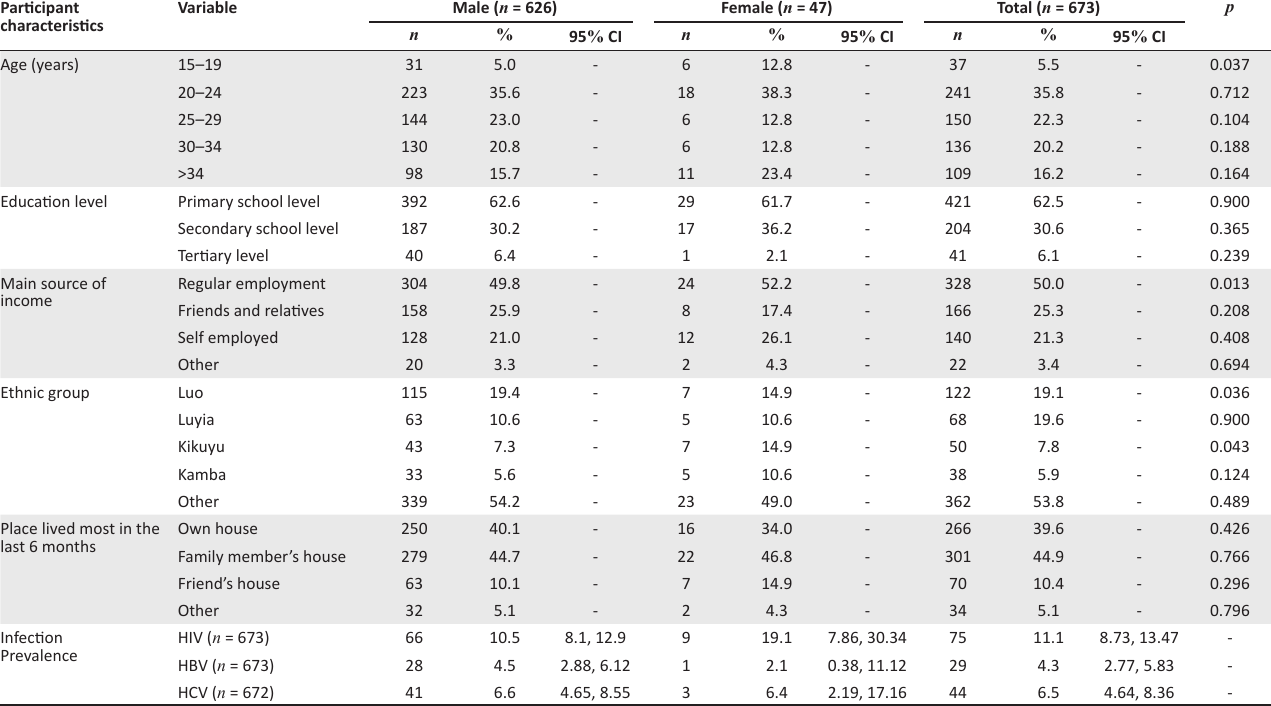
TABLE 1: Participant demographics and disease prevalence among drug users in three major cities in Kenya. Participant characteristics